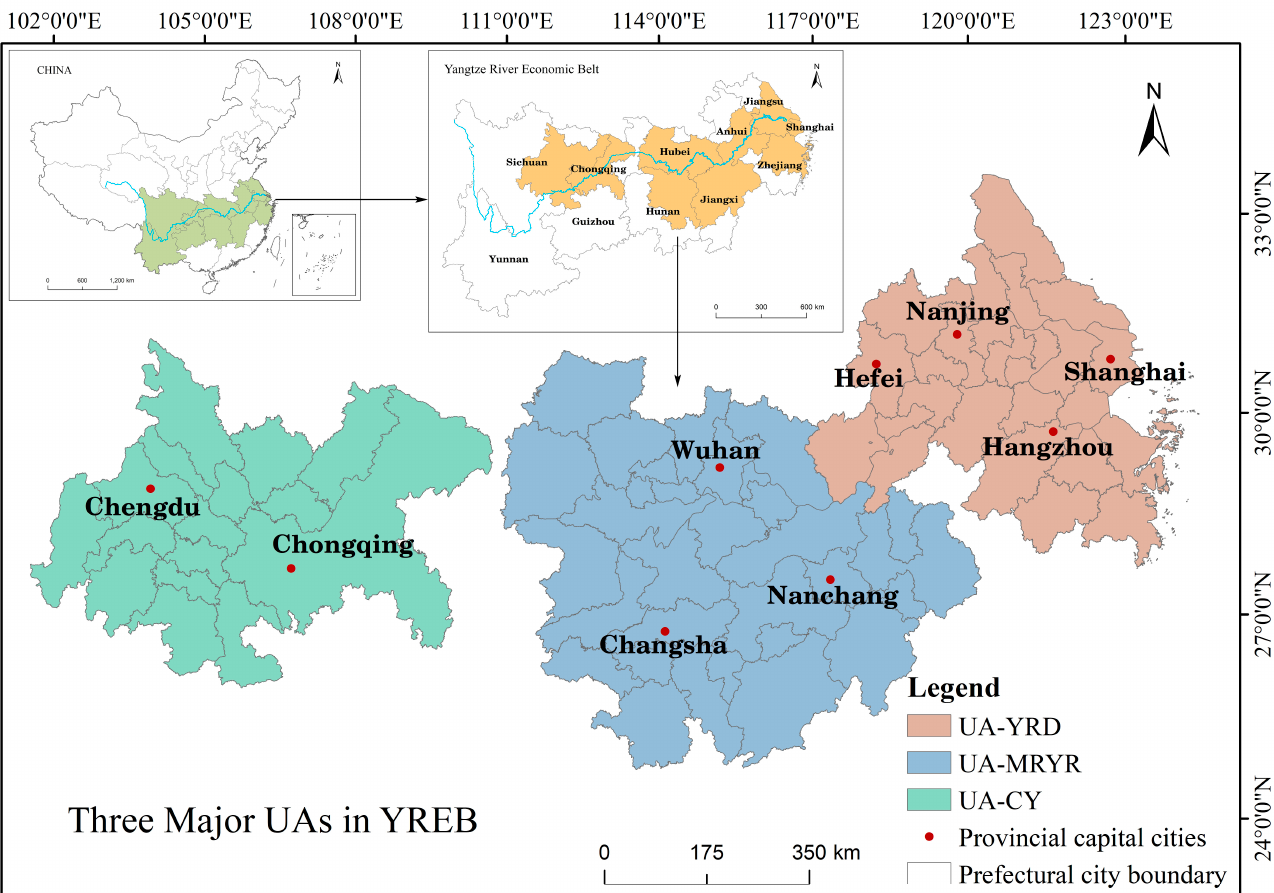
Figure 2. The location of the Yangtze River Economic Belt and its three major urban agglomerations.